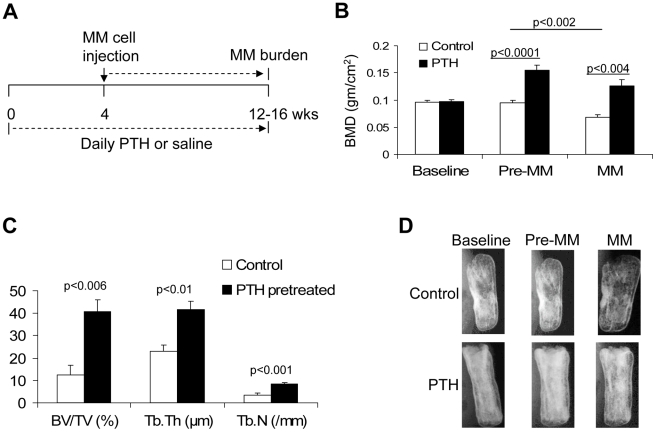
Bone formation induced by PTH pretreatment inhibits myeloma bone disease.SCID-rab mice (15/group) were treated with PTH or saline for 4 weeks and then were injected with myeloma cells (BN stroma-dependent myeloma cells, six mice/group; or myeloma cells from one of three patients, three mice/group for each patient's cells). (A) A schema demonstrating the experimental design. (B) BMD levels of the implanted bones were measured before PTH treatment was initiated (Baseline); after 4 weeks of PTH treatment, just before myeloma cell injection (Pre-MM); and 8–12 weeks after myeloma cell injection (MM). Note that PTH treatment increased BMD levels of implanted bones before inoculation with myeloma cells (Pre-MM), an effect that was retained after engraftment of MM in these bones (MM). (C) Static histomorphometric analysis of the implanted bones at the end of the experiment. (D) Representative X-ray radiographs of implanted bones at different stages of the experiments in three hosts treated with saline (Control) or PTH. Note that bone mass increased after treatment with PTH (Pre-MM) and that bone loss after MM engraftment was less profound in the PTH-pretreated group.